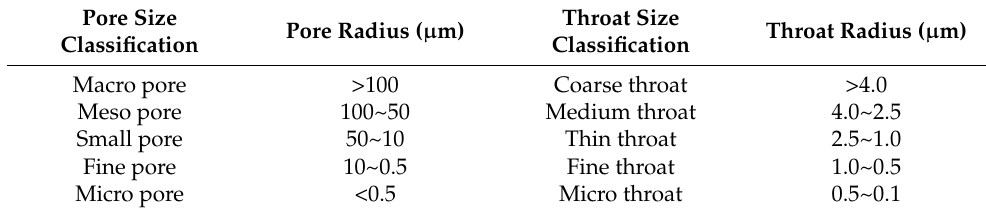
Table 1. Pore and throat size division scheme [19].